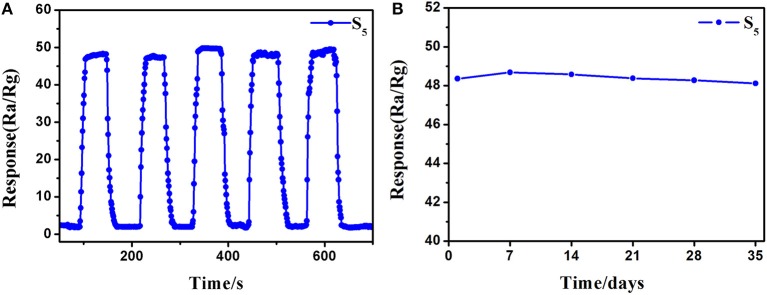
(A) Repeatability and (B) stability of (gas sensor S5) 0.16 wt% Pt doped SnO2 based gas sensor to 10 ppm 3-hydroxy-2-butanone at 250°C.